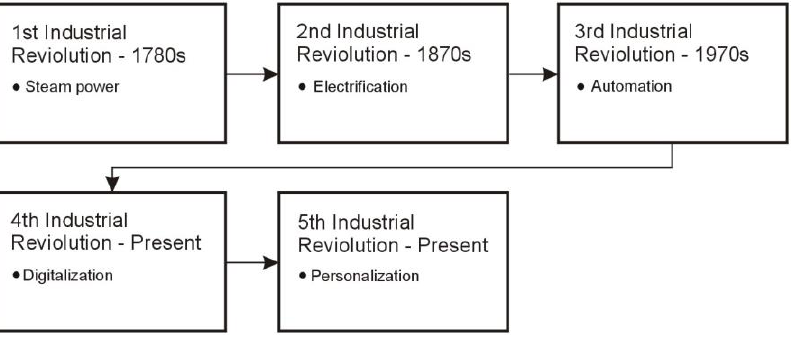
Figure 1. Industrial revolutions and their outcomes [19].